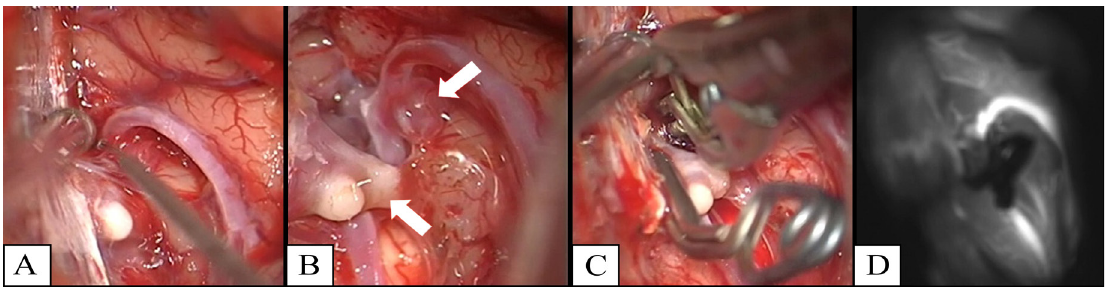
Figure 2. Surgical Clipping of Aneurysms – Intraoperative View.